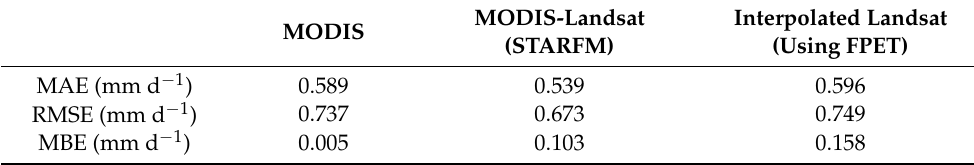
Table 2. Comparison of different daily ET retrievals modeled for the period 2013–2015.